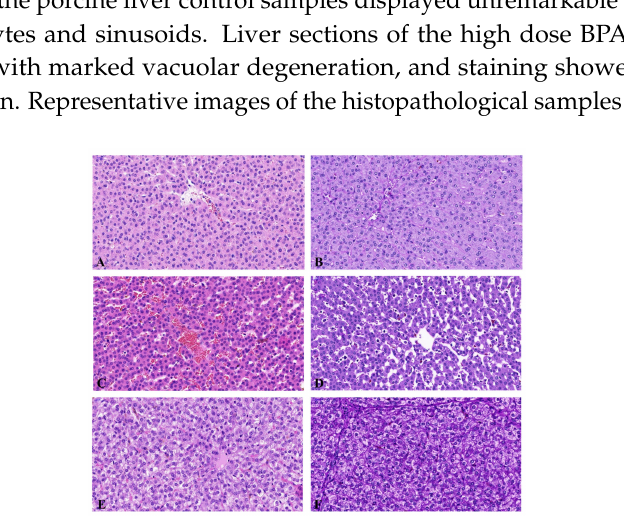
Figure 1. Histopathologic examination of the liver. ( A , B ) Liver sections of the control group show unremarkable liver histopathology. Periodic acid-Schiff (PAS) stain exhibits a positive stain of glycogen in the cytoplasm; ( C , D ) Liver sections of the low dose bisphenol A (BPA) group show dilated and congested central veins and hepatic sinusoids. PAS stain is normal with a positive cytoplasmic stain; ( E , F ) Liver sections of the high dose BPA experimental group show hepatocytes with marked vacuolar degeneration, PAS stain shows changes consistent with glycogen depletion; ( A , C , E ) 400 × ; H&E stain; ( B , D , F ) 400 × ; PAS